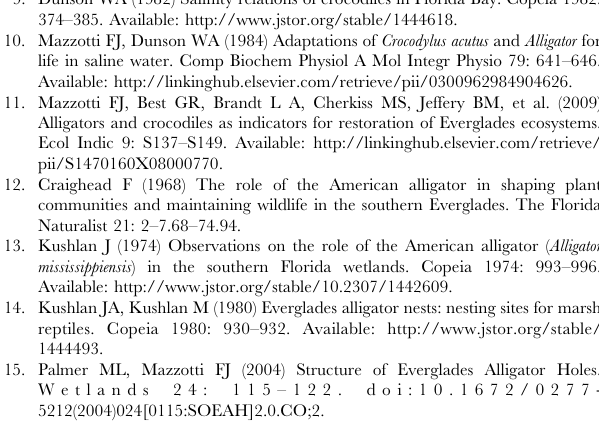
Table S1 Crittercam deployment data. Summary of all data from each individual American alligator outfitted with a Crittercam unit. Table S2 Alligator diel activities. Total time of usable video footage recorded, n the number of individuals the video data was recorded from, and the percent time observed performing basic activities. Table S3 Summary table of alligator diel activity. The cumulative (overall), minimum, and maximum percentage of time during daytime intervals alligators’ were observed performing basic